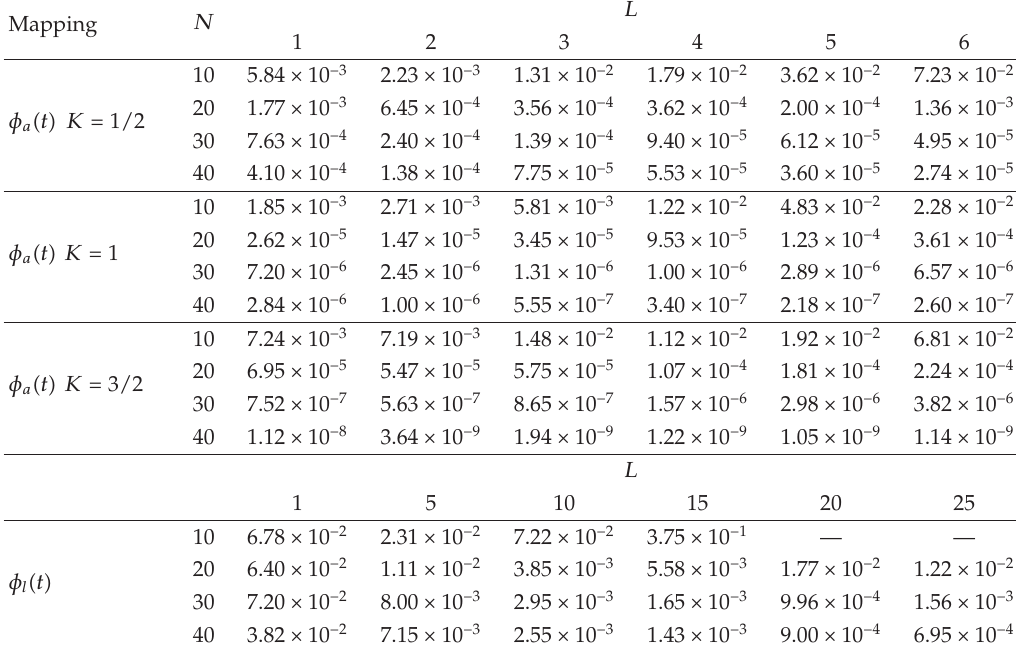
Table 3: Maximum absolute errors for Example